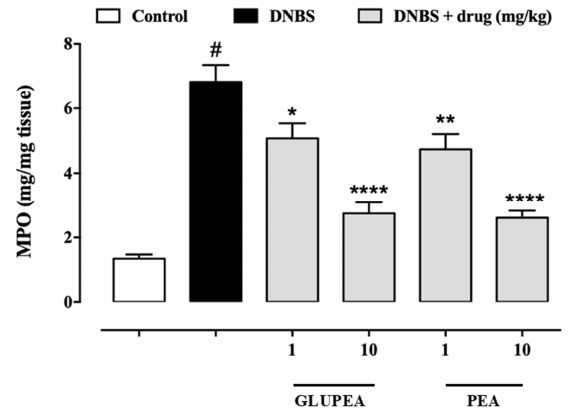
Figure 7. Effect of GLUPEA on the MPO activity in DNBS-induced colitis in mice. MPO activity was measured on colonic tissues 3 days after vehicle or DNBS injection. PEA-um (1–10 mg kg − 1 ), or GLUPEA (1–10 mg kg − 1 ) was administered by oral gavage once a day for three consecutive days starting 24 h after the inflammatory insult. Data are the mean + s.e.m. of a single experiment, with 15 mice for each experimental group. Statistical analyses were carried out using one-way ANOVA followed by Dunnett’s multiple comparisons test ( # p < 0.0001 versus control (i.e., mice without intestinal inflammation); * p < 0.05, ** p < 0.01, **** p < 0.001, versus DNBS).